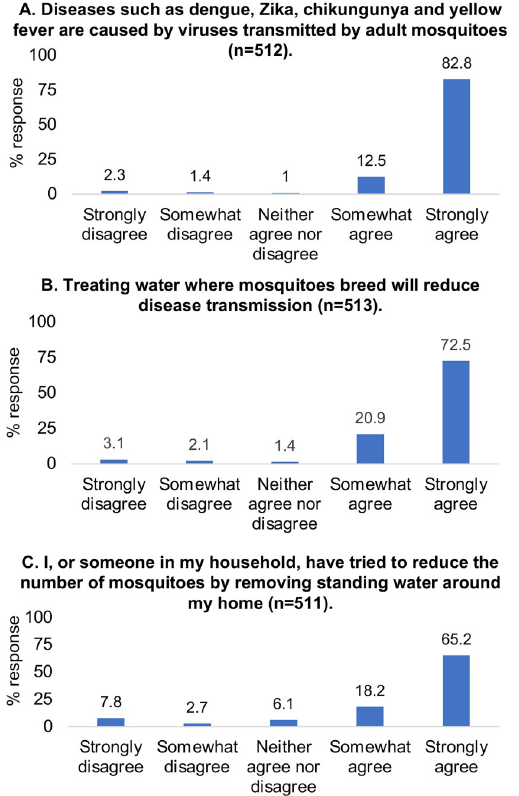
Fig 3. Paper survey responses to general mosquito knowledge questions. A summary of responses to the first three paper survey questions, all of which assessed general mosquito knowledge, is